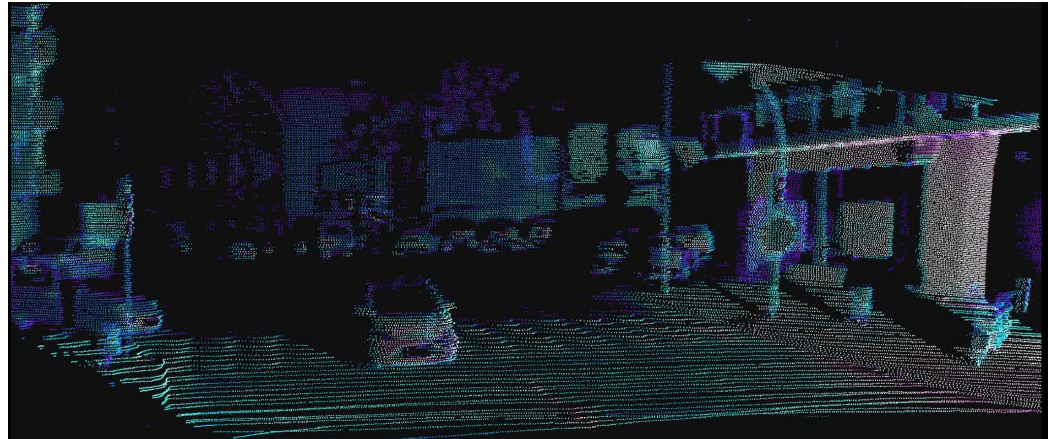
Figure 13. Lidar imaging with 1 mrad spatial resolution in vertical and horizontal directions